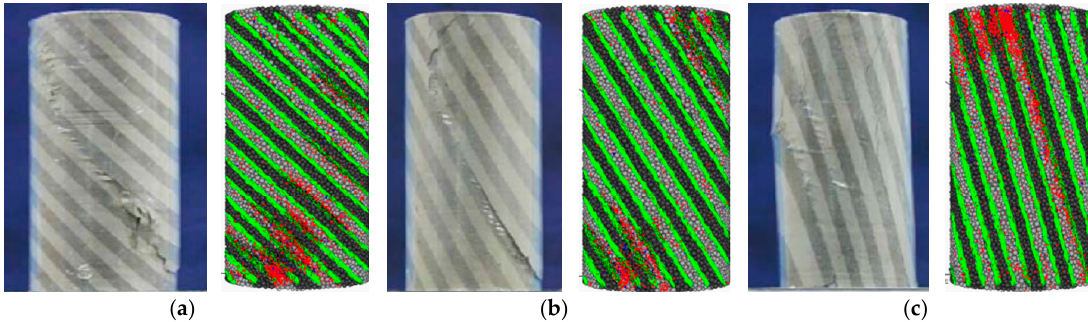
Figure 11. Failure modes of transversely isotropic jointed rock models having dip angles of ( a ) α = 45°, ( b ) α = 60°, and ( c ) α = 75°. (Note that the failure images of physical samples were adopted from Ref. [23]).